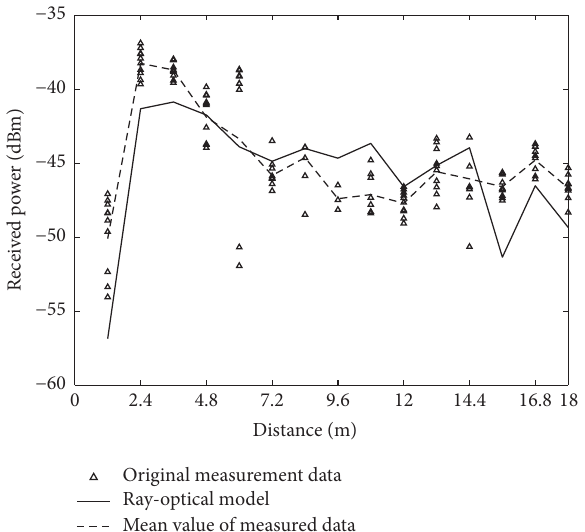
Figure 11: Received power versus link distance with different